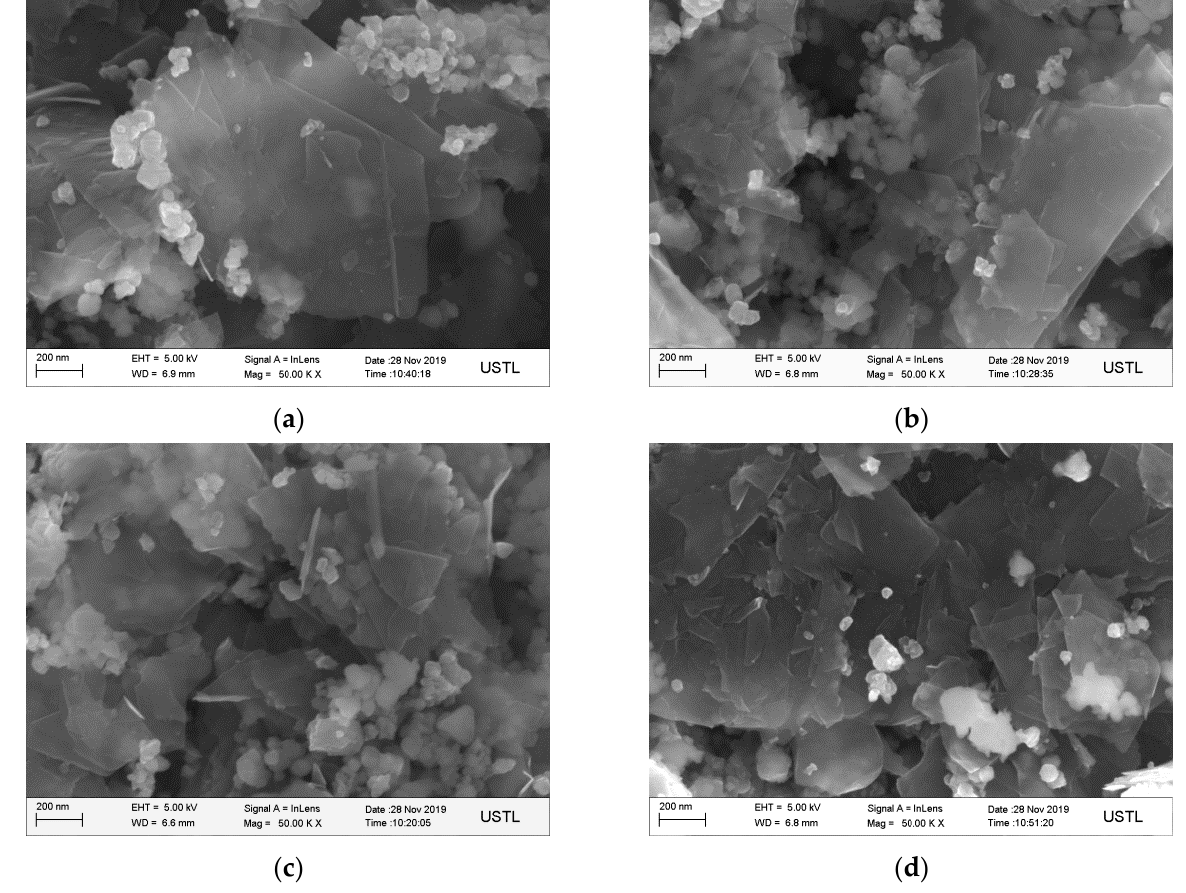
Figure 4. SEM morphology of graphene-coated SiC nanoparticles at different rotational speeds. ( a ) 160 rpm; ( b ) 180 rpm; ( c ) 240 rpm; ( d ) 280 rpm.